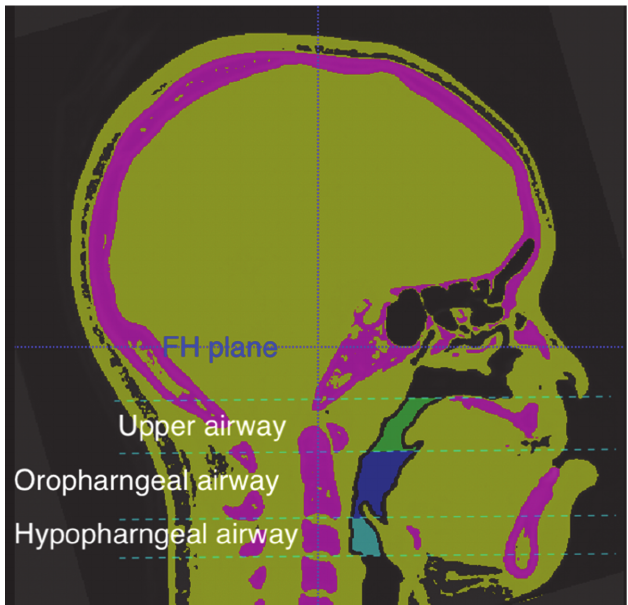
Figure 2. The midsagittal view in Case-3 displays various regions of the segmental airway. The landmarks are defined as follows. (1) Upper airway (in green color): extending from the posterior nasal spine to the lowermost protruding part of C1. (2) Oropharyngeal airway (in navy blue color): extending from the lowermost protruding part of C1 to the lowermost protruding part of C2. (3) Hypopharyngeal airway (in light blue color): extending from the lowermost protruding part of C2 to the lowermost protruding part of C3.